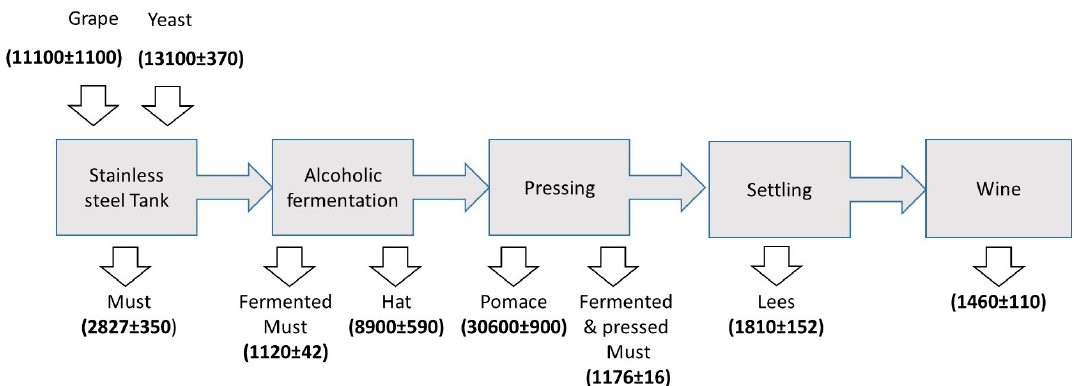
Figure 1. Evolution of potassium content (on a dry mass basis) along the winemaking process. The figures in bold correspond to the potassium concentration expressed as mg kg − 1 . Confidence intervals have been determined according to: ± t s √ ( n = 4; t for a 99% confidence level: 3.74).